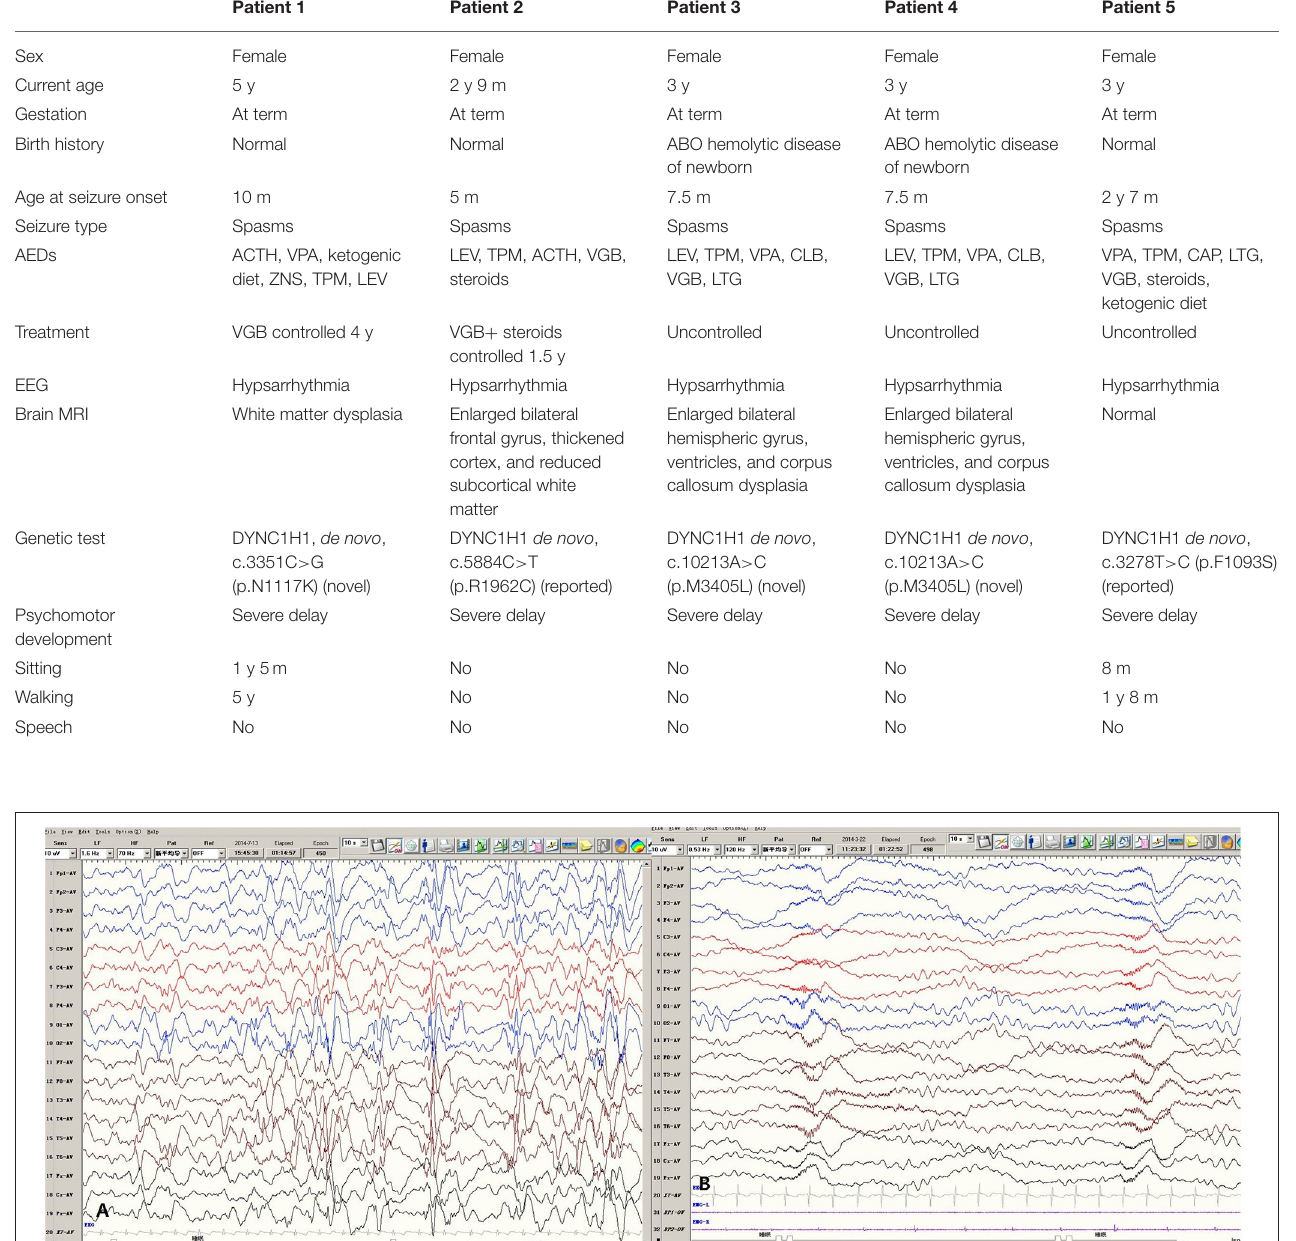
EEG data for five patients all showed hypsarrhythmia ( Figure 2 ). Brain MRI was abnormal in patients 1–4 and normal in patient 5. Brain MRI showed white matter dysplasia and developmental regression in patient 1; enlarged bilateral frontal gyrus, thickened cortex, and reduced subcortical white matter in patient 2; and enlarged bilateral hemispheric gyrus,